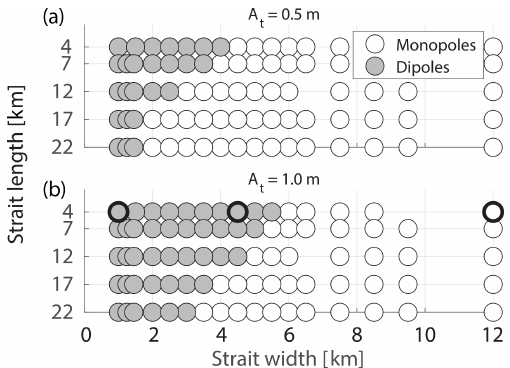
Figure 4. Overview of all simulations performed in this study. Gray marks simulations in which self-propagating dipoles are formed. Panels (a, b) display simulations forced with a tidal wave height amplitude of A t = 0 . 5 and A t = 1m, respectively. The three thick black circles mark the three simulations shown in Figs. 5 to 7.